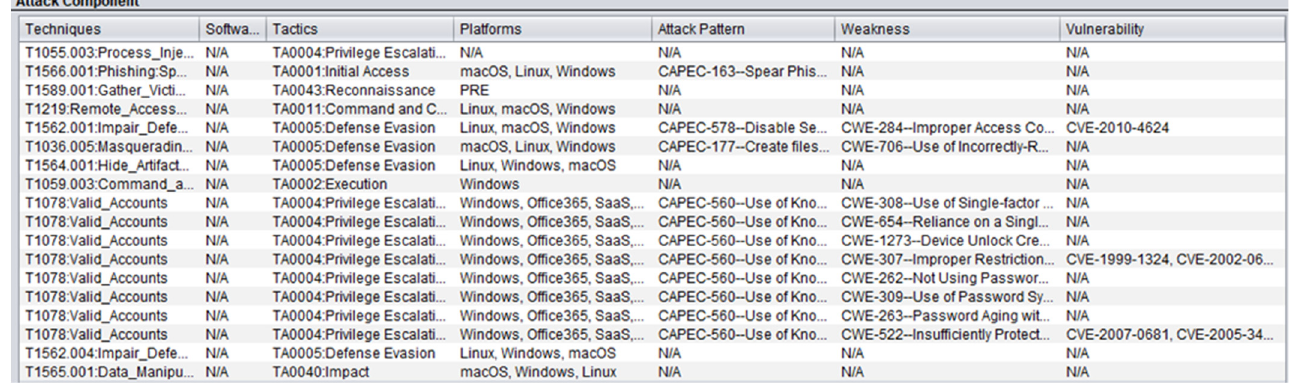
Figure 10. Attack component results.